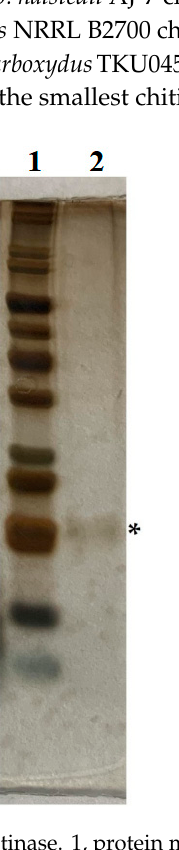
Figure 3. SDS-PAGE analysis of TKU048 exochitinase. 1, protein markers; 2, purified exochitinase after HPLC; *, location of purified TKU048 exochitinase.